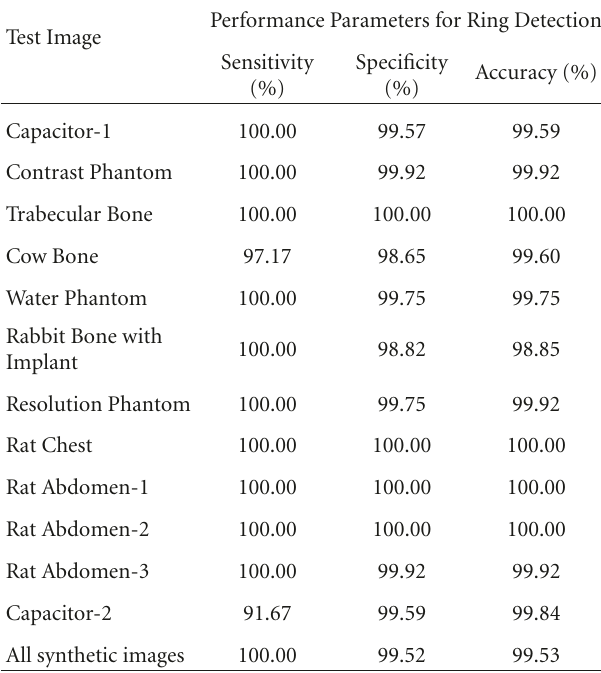
Table 2: Accuracy of the proposed detection